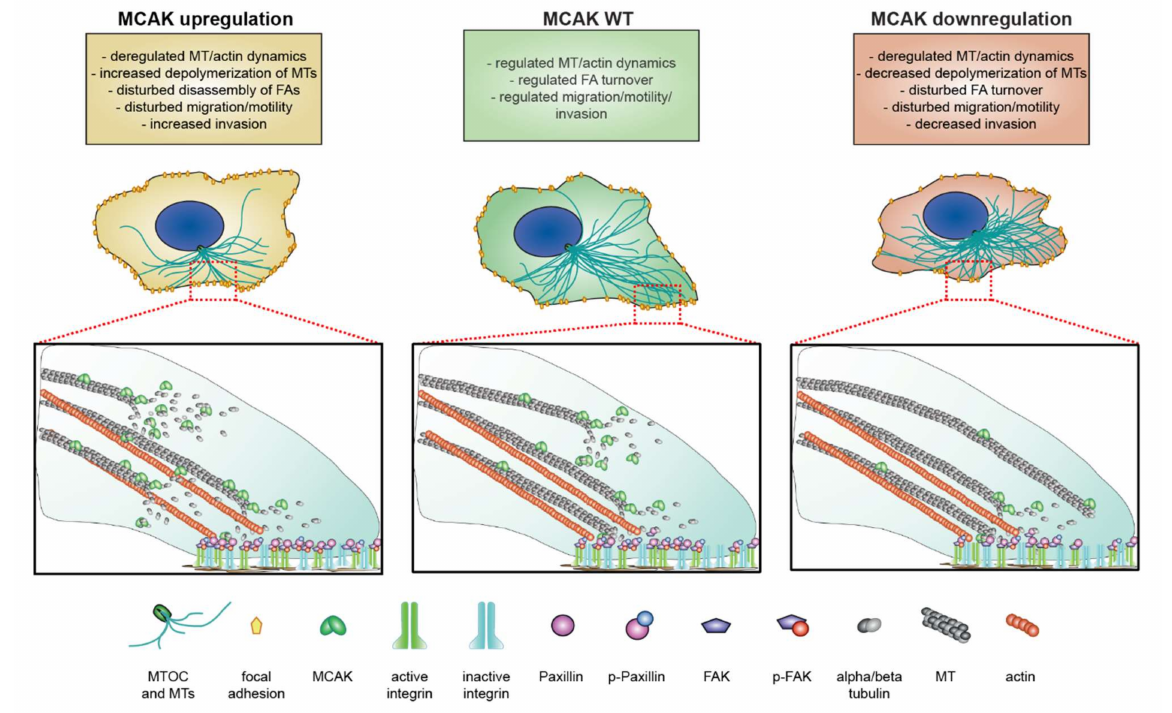
Figure 8. Deregulation of MCAK causes impaired motility and migration capacity, induced by altered MT dynamics and FA assembly as well as disassembly. Proposed working model of MCAK regulating FA assembly and disassembly by modulating the MT dynamics. Interfering with the expression of MCAK (overexpression: yellow; knockdown: red) leads to disturbed paxillin/p-paxillin/FAK/p-FAK levels in FAs. Moreover, the impaired MT dynamics are associated with delayed cell spreading and adhesion. The altered formation of stable FAs results in an uncoordinated assembly and disassembly of FAs during the migration/invasion process, compromising cell